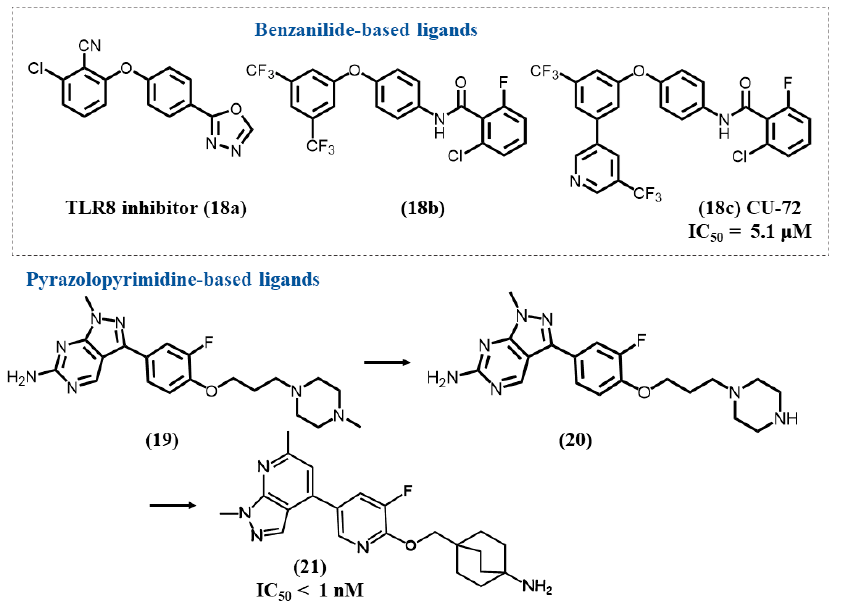
Figure 6. Structures of benzanilide-based ligands and SAR studies of pyrazolopyrimidine/pyridine derivatives.